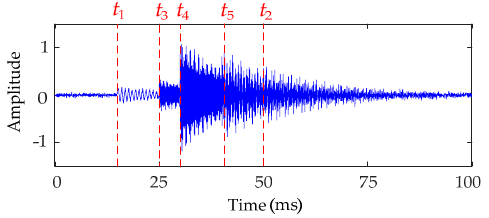
Figure 3. The waveform of the simulated HVCB vibration signal.